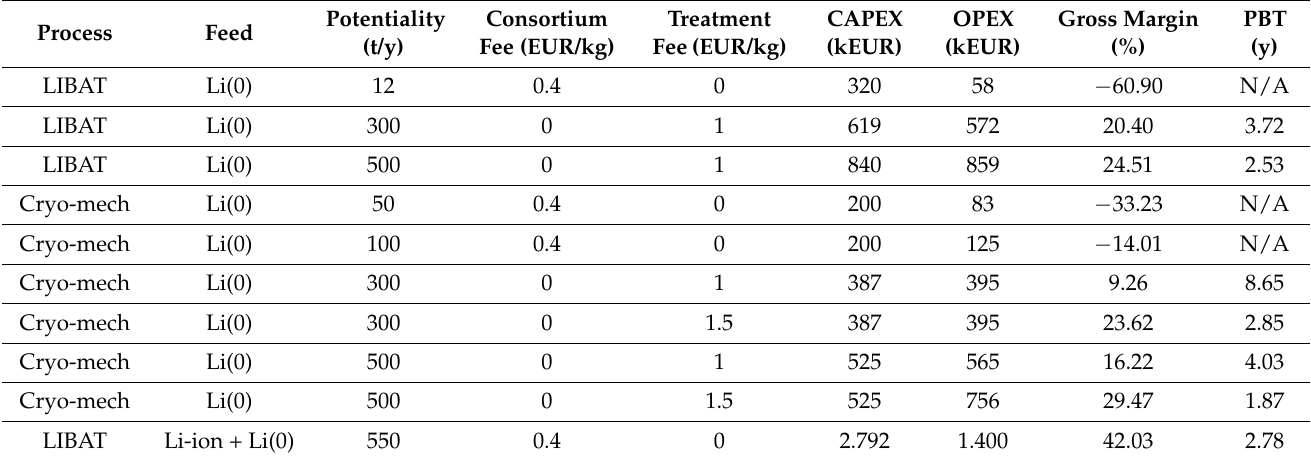
Table 2. List of adopted conditions for process simulations